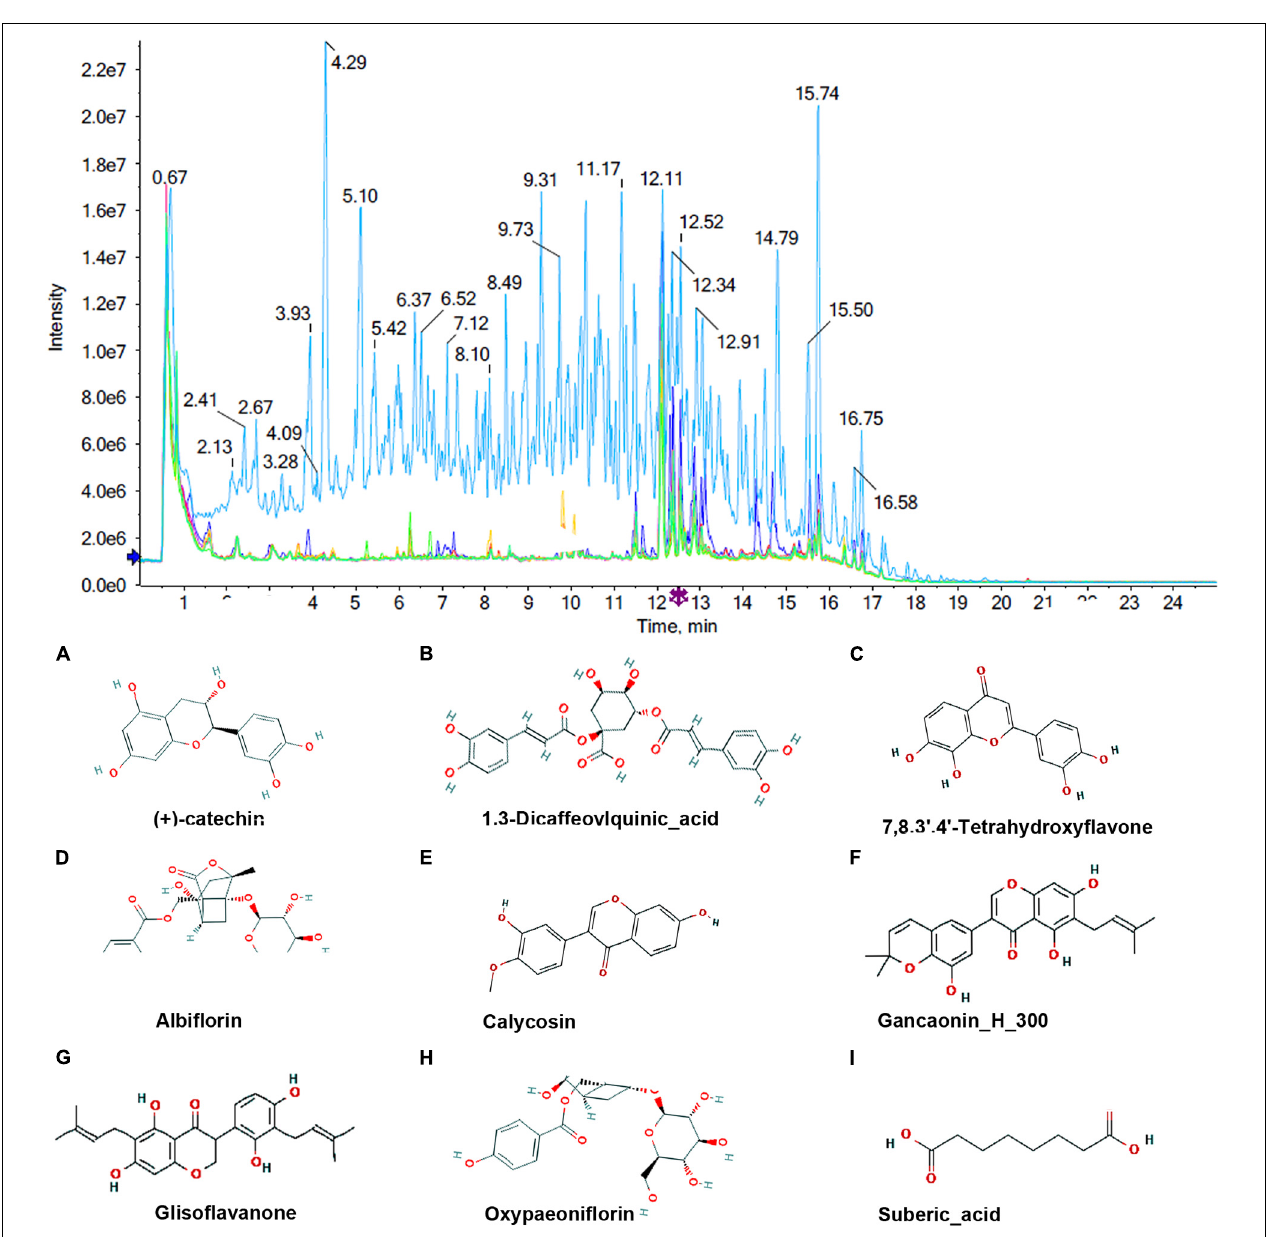
FIGURE 4 | Chromatograms and chemical structures of MBP metabolites in the transitional milk of sows after dietary supplementation of MBP. The chromatograms in negative mode. (A–I) Absorbed milk components (+)-catechin, 1.3-Dicaffeovlquinic_acid 7,8.3.4-Tetrahydroxyflavone, Albiflorin, Calycosin, Gancaonin, Glisoflavanone, Oxypaeoniflorin and